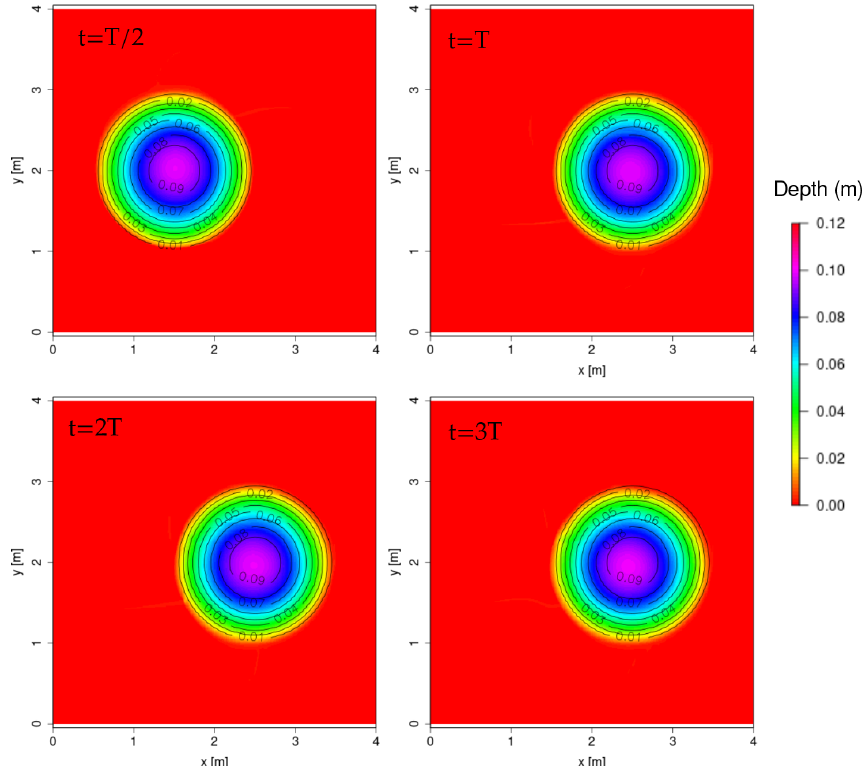
Figure 7. Planar surface in a paraboloid: snapshots of water depth by the model compared to the analytical solution (contour lines). Period T = 2.242851s.